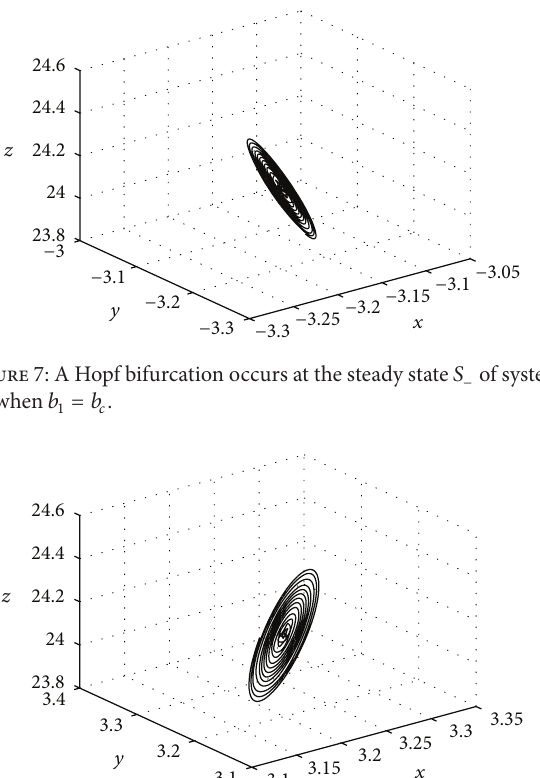
Figure 4: The steady state 𝑆 + of system (4) is locally asymptotically stable when 𝑏 1 < 𝑏 𝑐 .